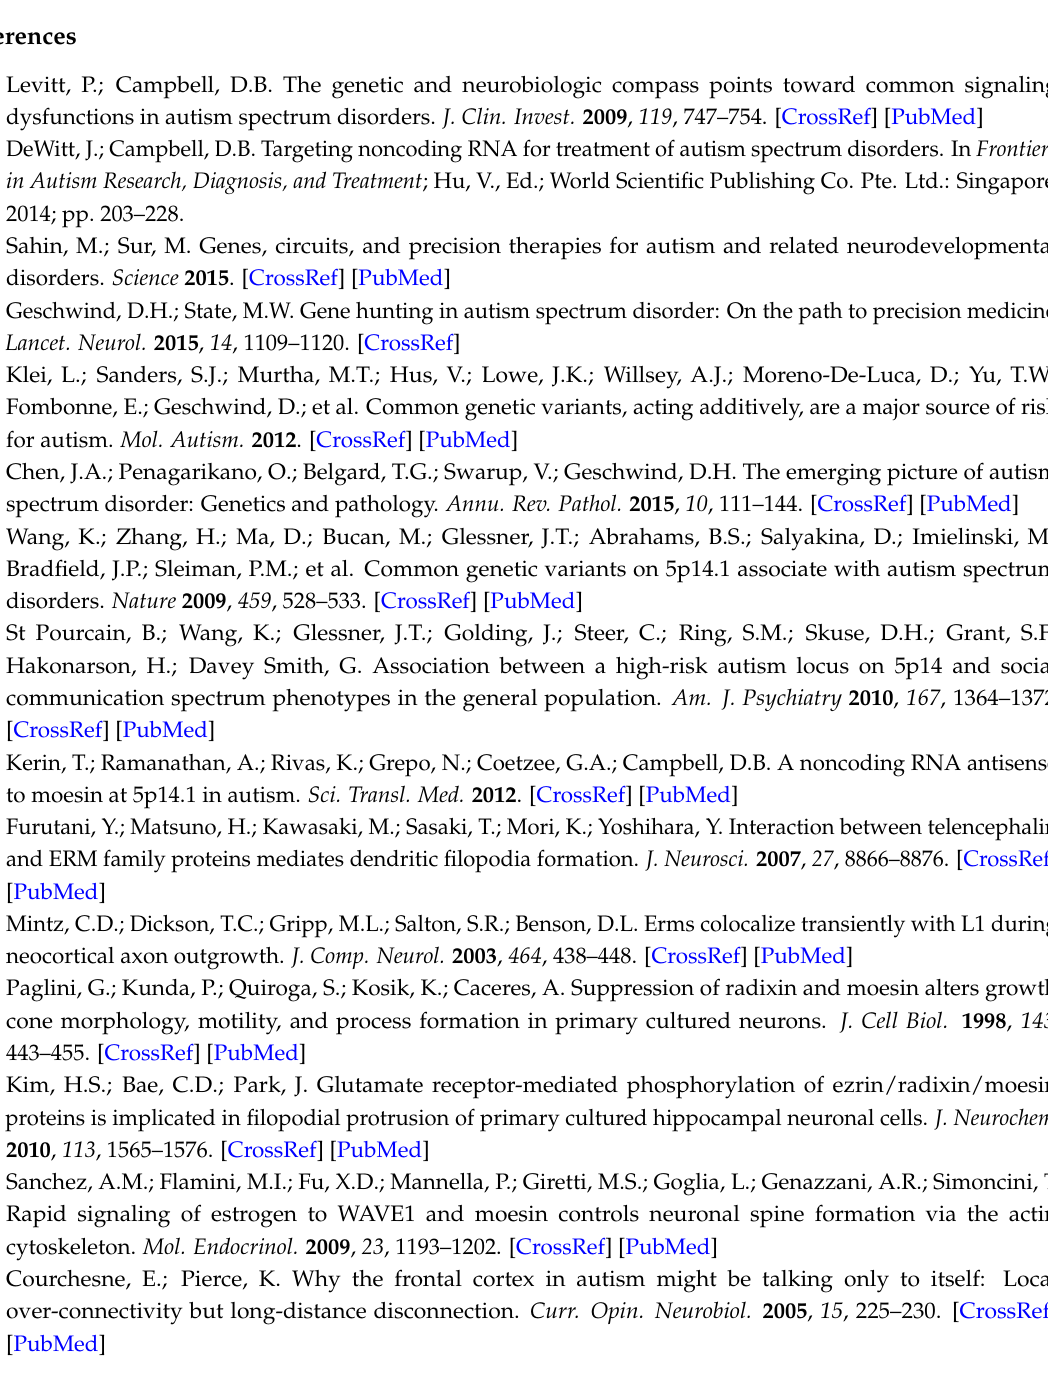
Table S1: RNA sequencing metrics, Table S2: quantitative over-expression of MSNP1AS , Table S3: genes differentially expressed following MSNP1AS over-expression, Table S4: gene networks differentially expressed following MSNP1AS